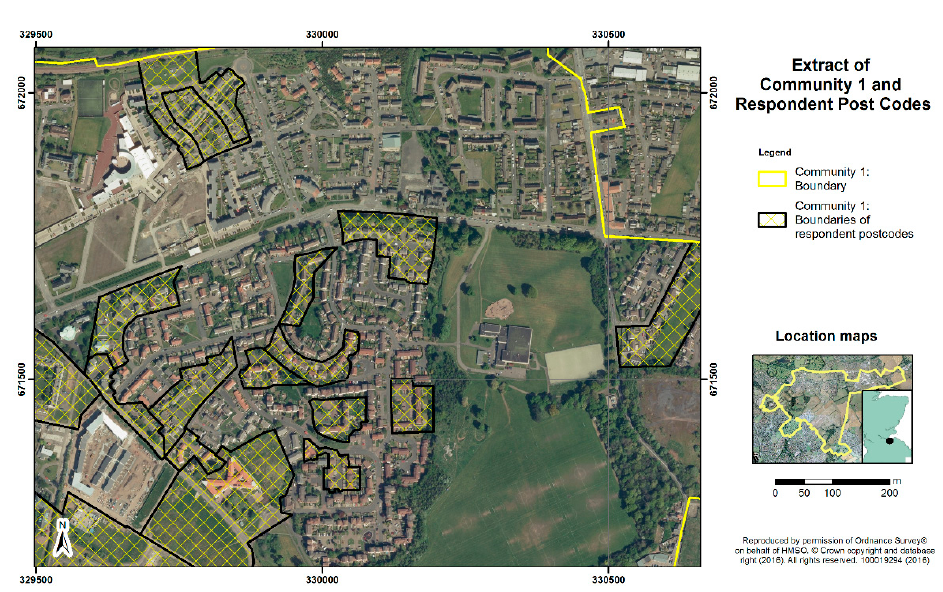
Figure 1. Aerial view of typical residential neighbourhood in Community 1.